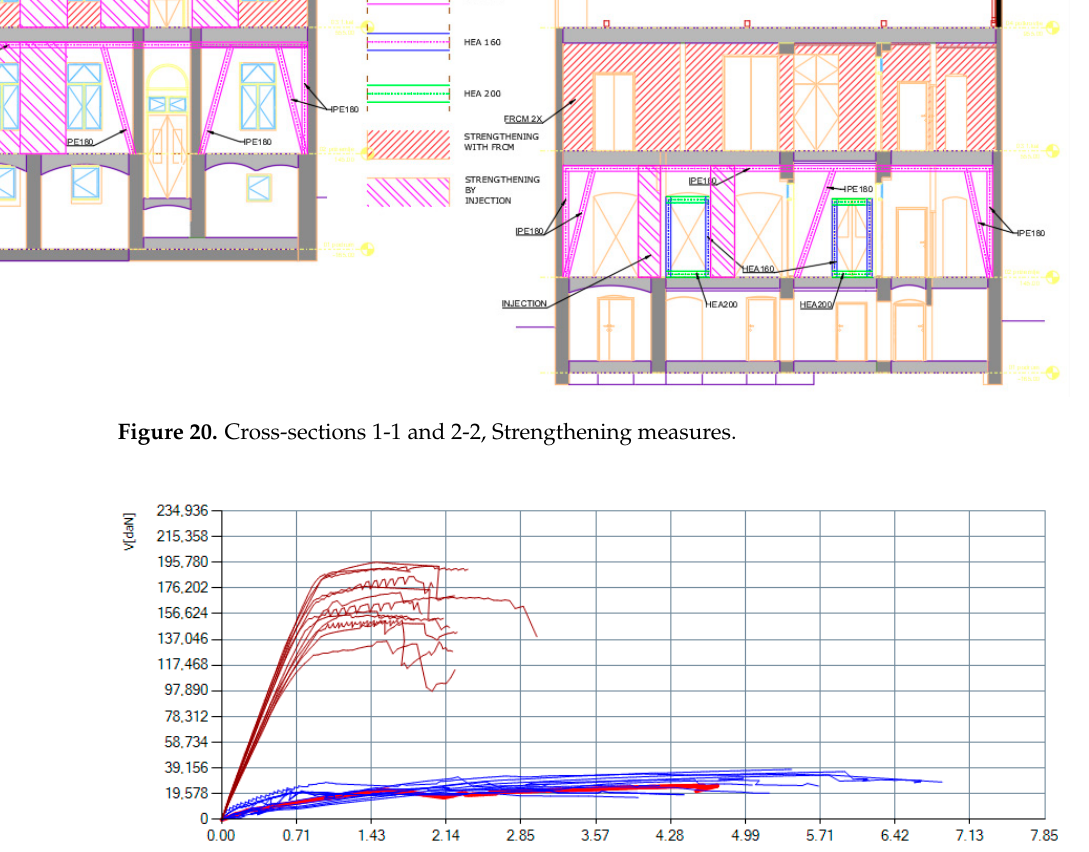
Figure 21. Capacity curves in the X and Y directions of the strengthened structure.